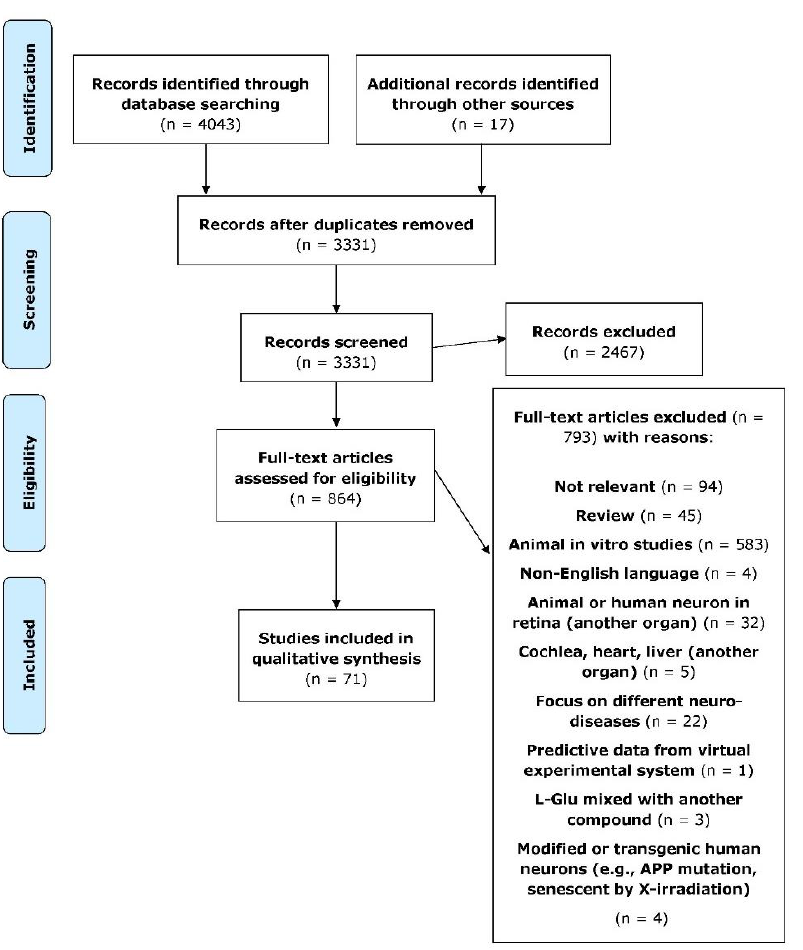
Figure 1. Preferred Reporting Items for Systematic Reviews and Meta-Analyses (PRISMA) flowchart illustrating the processes of data collecting and selection [50] .